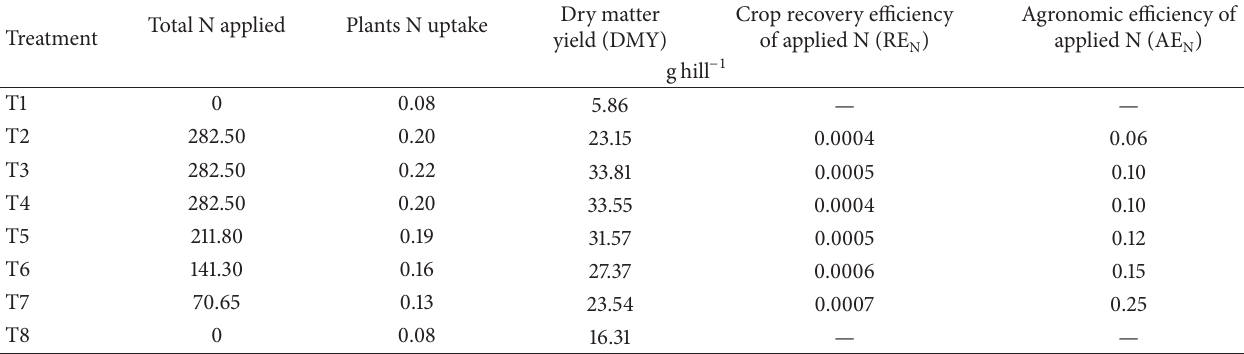
Table 12: Effects of nitrogen application on crop recovery and agronomic efficiency under pot trial. Treatment